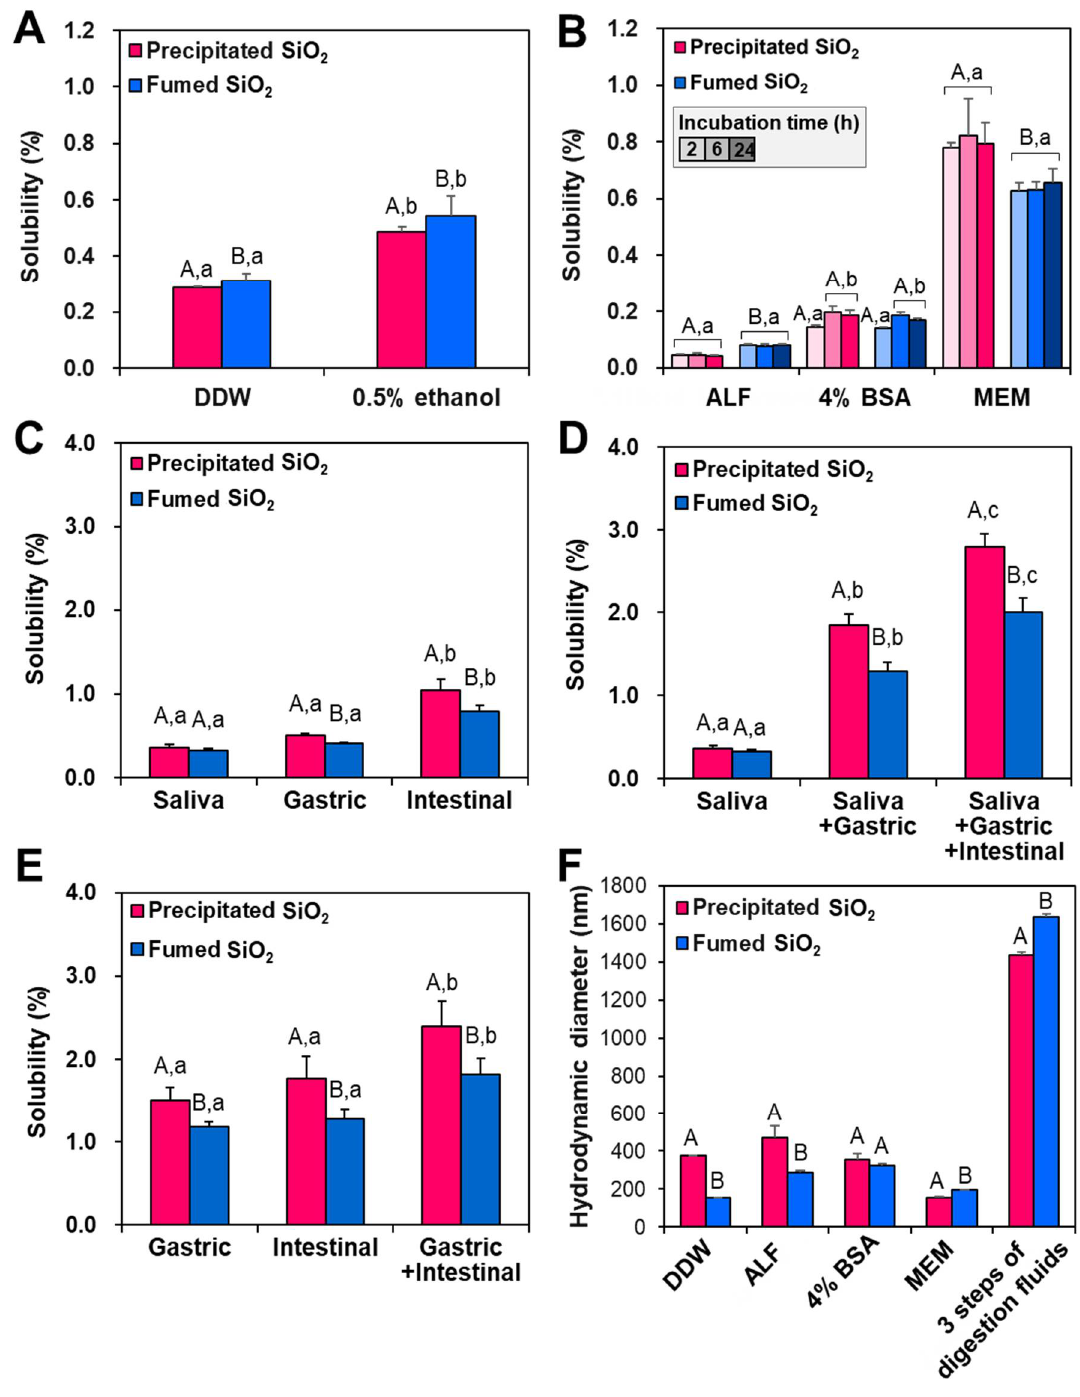
Figure 2. Dissolution properties of precipitated SiO 2 and fumed SiO 2 in ( A ) distilled and deionized water (DDW) and 0.5% ethanol; ( B ) artificial lysosomal fluid (ALF), 4% bovine serum albumin (BSA) solution, and minimum essential medium (MEM); ( C , D ) in vitro digestion fluids; and ( E ) ex vivo rat-extracted gastrointestinal (GI) fluids. ( F ) Hydrodynamic diameters of precipitated SiO 2 and fumed SiO 2 in DDW, ALF, 4% BSA solution, MEM, and three consecutive steps of in vitro digestion fluids. Different uppercase letters (A,B) indicate significant differences between precipitated SiO 2 and fumed SiO 2 under the same conditions ( p < 0.05). Different lowercase letters (a,b,c) indicate significant differences between experimental conditions ( p <